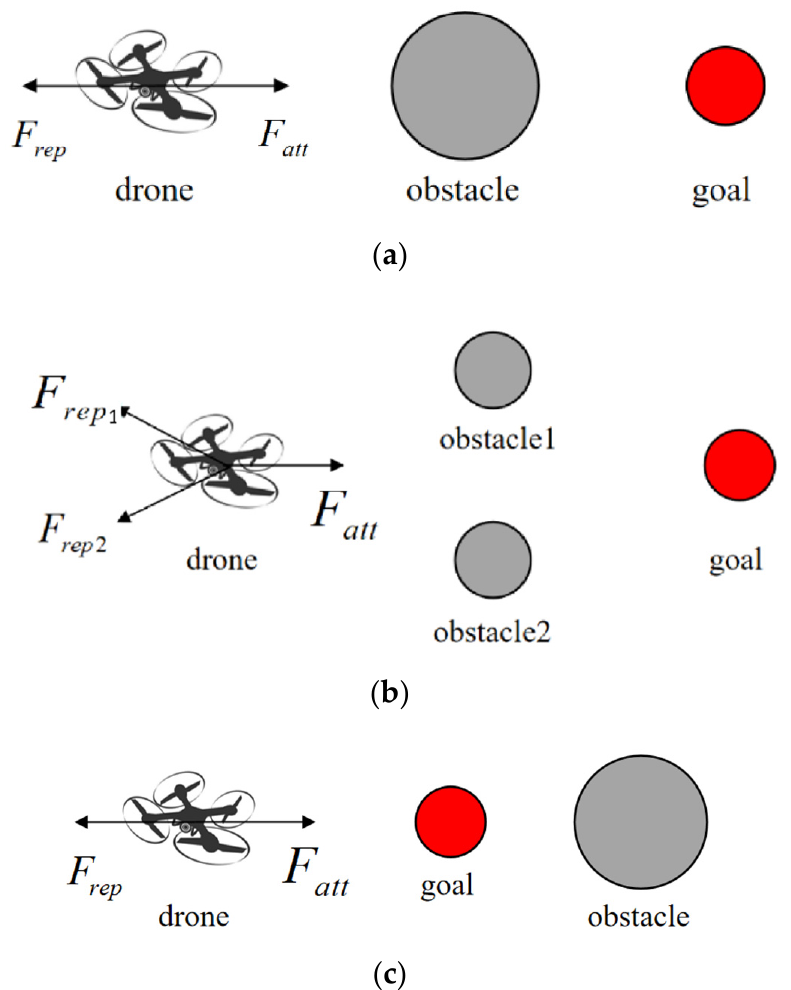
Figure 12. Artificial-potential-field method falls into the local-optimum case. ( a ) The obstacle is directly in front of the target point and on the same course as the drone. ( b ) Obstacles are on both sides of the drone. ( c ) The obstacle is behind the target point and on the same course as the drone.